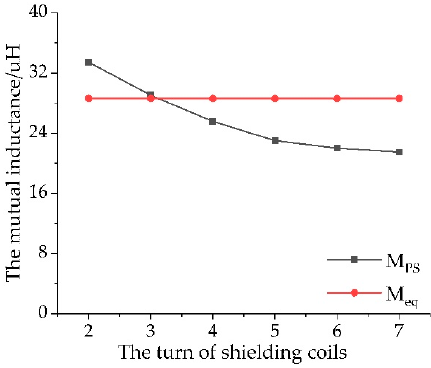
Figure 3. M PS and M eq change with the turn of shielding coils.